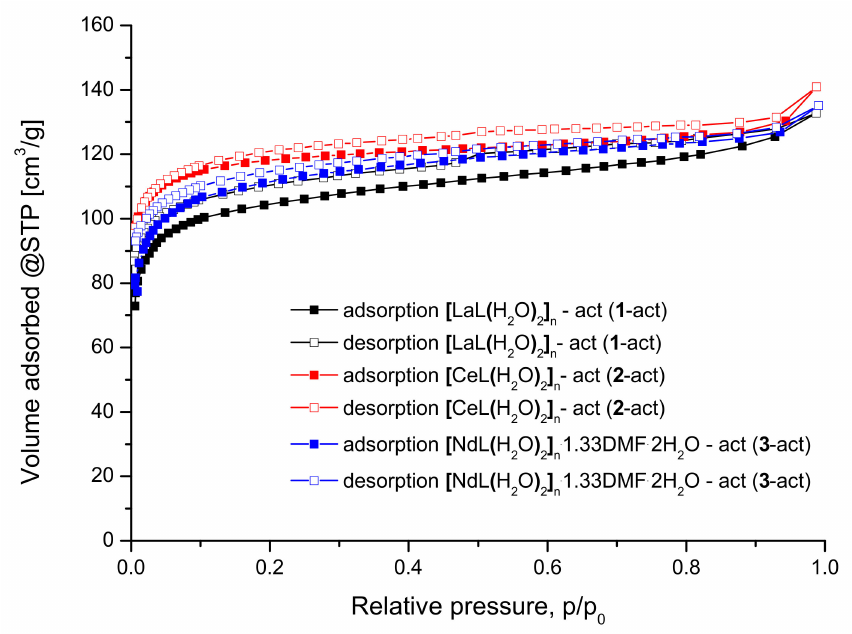
Figure 4. N 2 sorption isotherms of the activated compounds of 1 – 3 at 77 K. Closed and open symbols refer to adsorption and desorption,